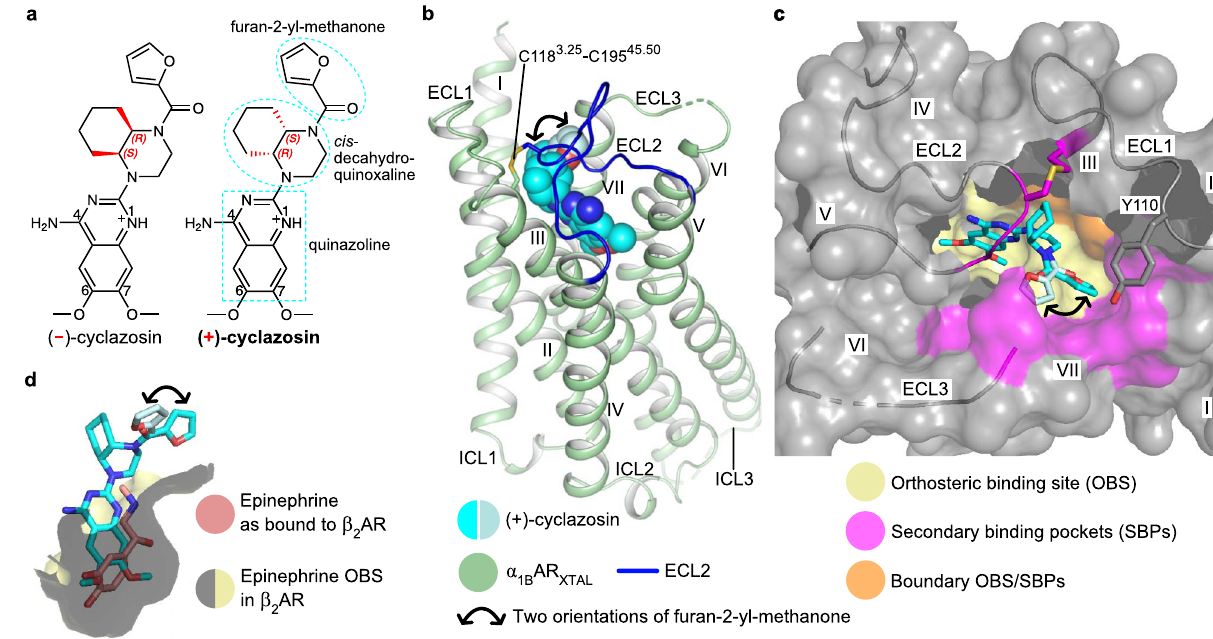
Fig. 1 Structure of α 1B AR XTAL bound to ( + )-cyclazosin and overview of the ligand-binding site. a Chemical structure of ( − )- and ( + )-cyclazosin. N1 is expected to be mostly protonated at the crystallization pH of 6.0 (see “ Methods ” ) as well as at physiological pH, and the resulting positive charge will be delocalized over the quinazoline ring system 49 – 51 . b Structure of α 1B AR XTAL bound to ( + )-cyclazosin. For clarity, DARPin D12 has been omitted. ( + )-Cyclazosin is depicted as van der Waals spheres. The two orientations observed for the furan-2-yl-methanone substituent of ( + )-cyclazosin are colored in cyan and pale cyan, respectively, and are indicated by a black curved arrow. Oxygen, nitrogen, and sulfur atoms are depicted in red, blue, and yellow, respectively. ECL, extracellular loop; ICL, intracellular loop. c Surface representation of the ( + )-cyclazosin binding site in α 1B AR XTAL . ECL1 – 3 are shown as surface and as cartoon; ( + )-cyclazosin is shown as sticks. The orthosteric binding site (OBS) has been approximated on the basis of the β 2 AR-epinephrine complex (see panel d and main text). d Comparison of the binding modes of ( (PDB ID: 4LDO 30